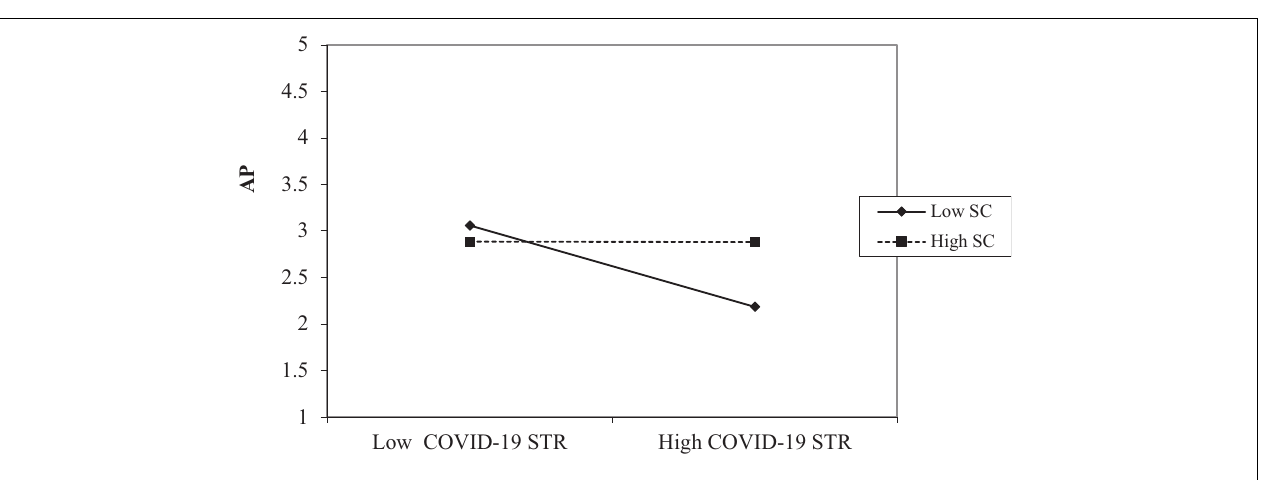
FIGURE 4 | Interaction effects of COVID-19 STR and SC on adaptive performance